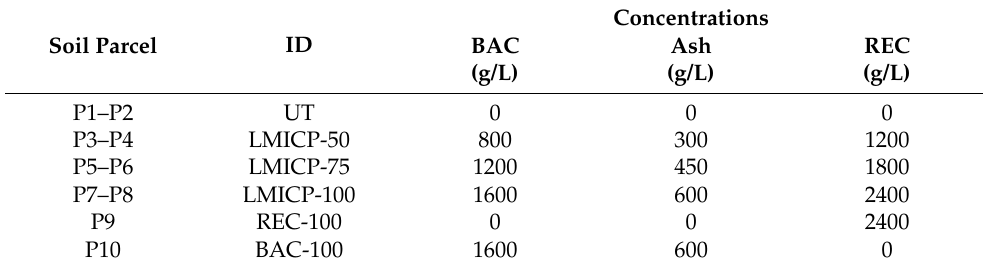
Table 4. Proportions of biotechnological products for field